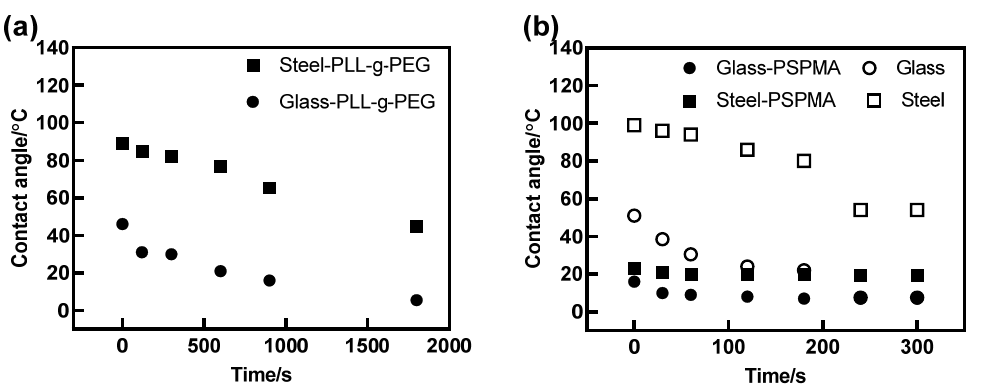
Figure 2. Contact angle of two polymers on glass and steel surfaces. ( a ) Surface lubricated by polymer PLL-g-PEG lubricating fluid; and ( b ) surface modified by polymer PSPMA brushes.